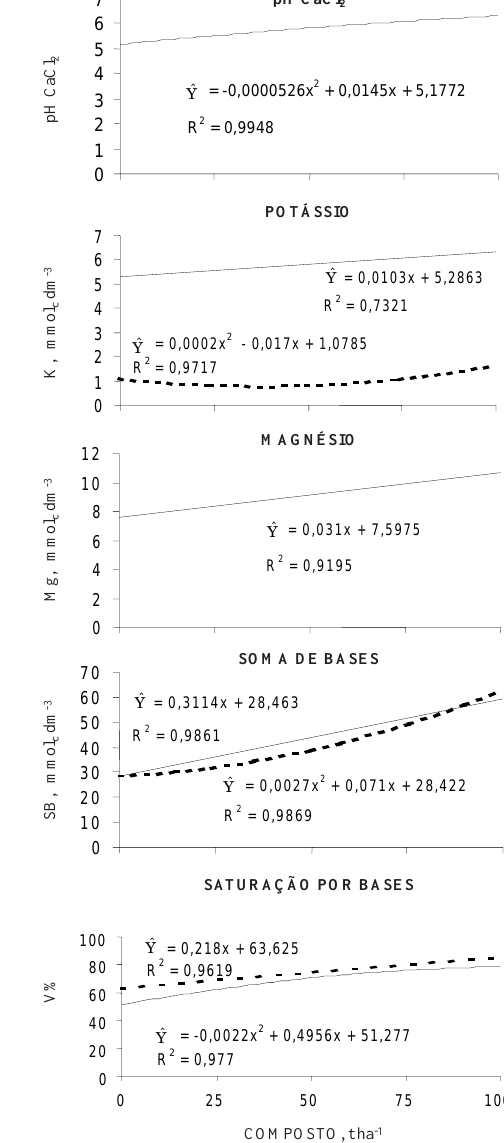
Figura 1. Efeito do composto de lixo urbano, na ausência (- - -) e na presença (----) de adubação mineral nas propriedades químicas do solo, variáveis com apenas uma regressão indicam ausência de interação